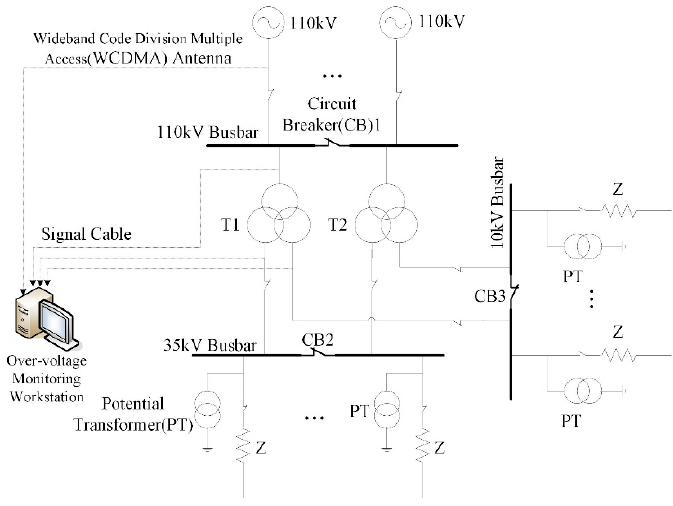
Figure 1. Wiring diagram of monitoring system in the substation.